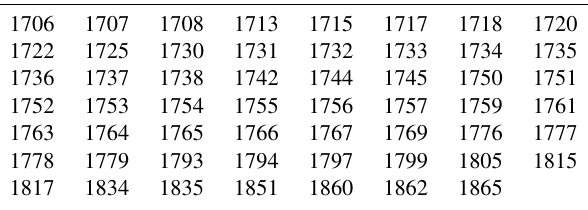
Table B2. Years at or above the 67th percentile of SPEI (wetter conditions) during the years 1702–1865.